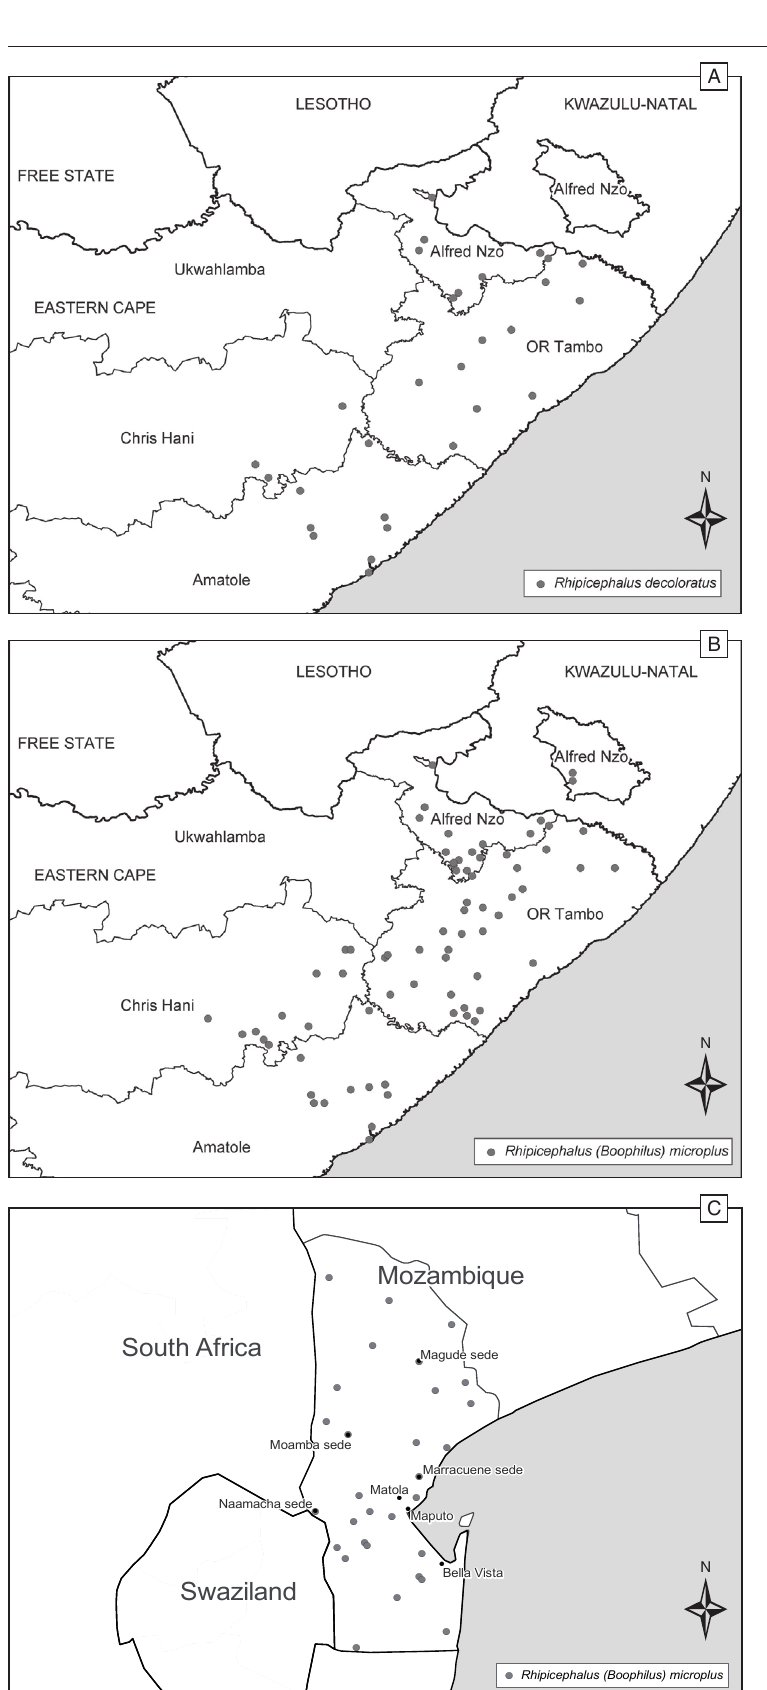
The geographic distribution of Rhipi cephalus ( Bo oph i lus ) decolor atus in (A) the eastern region of the Eastern Cape Province, South Africa, and of Rhipicephalus ( Bo oph ilus mi­ cro plus in (B) the eastern region of the East- ern Cape Province and (C) Maputo Prov